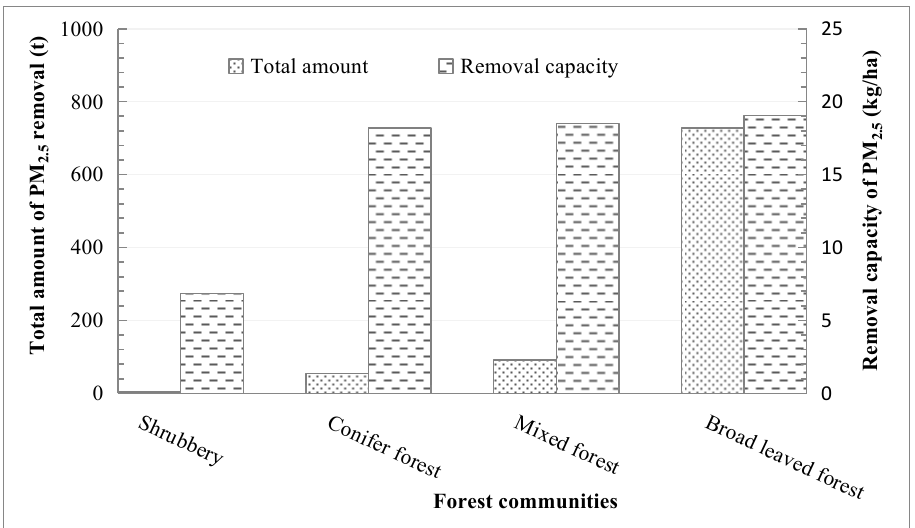
Figure 5. Amount of PM 2.5 removed by the urban forests in the city of Shanghai.